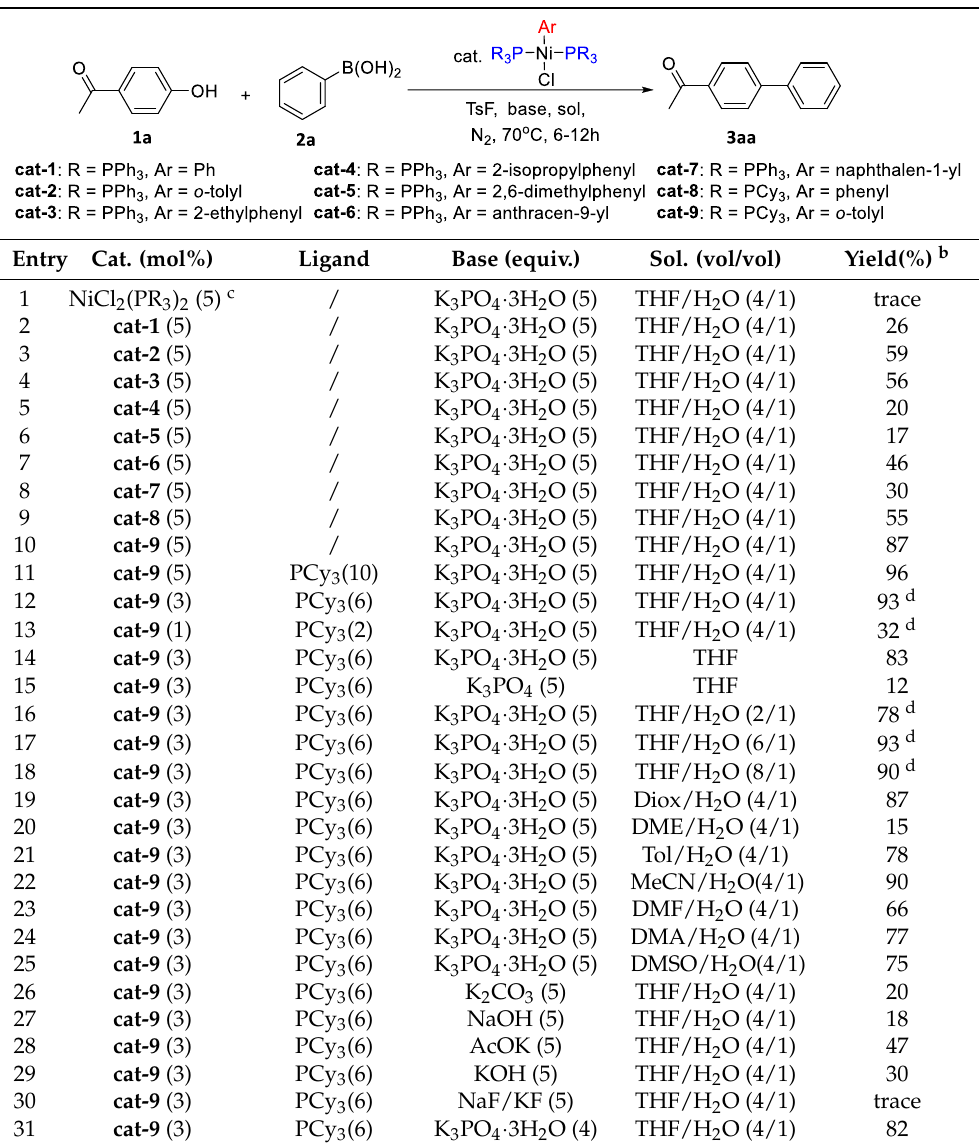
Table 1. Optimization of the SuFEx-enabled, Ni-catalyzed Suzuki coupling of phenols a .